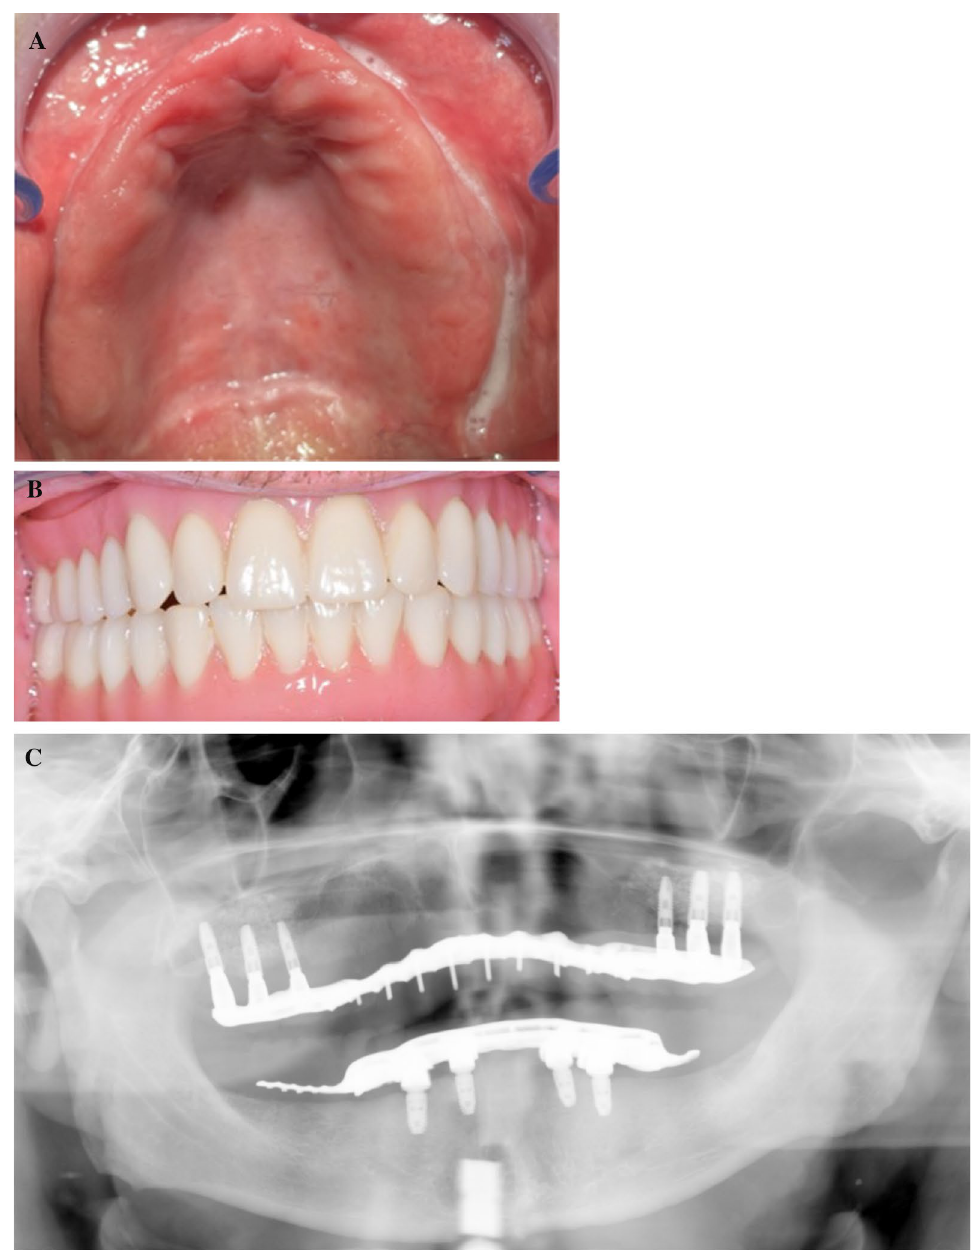
Fig. 5 Final overview of restorative dental care. A Palatal view of the bar prosthesis in the maxilla. B Frontal view of the final situation. C Panoramic radiograph showing good integration of the augmentation material and the